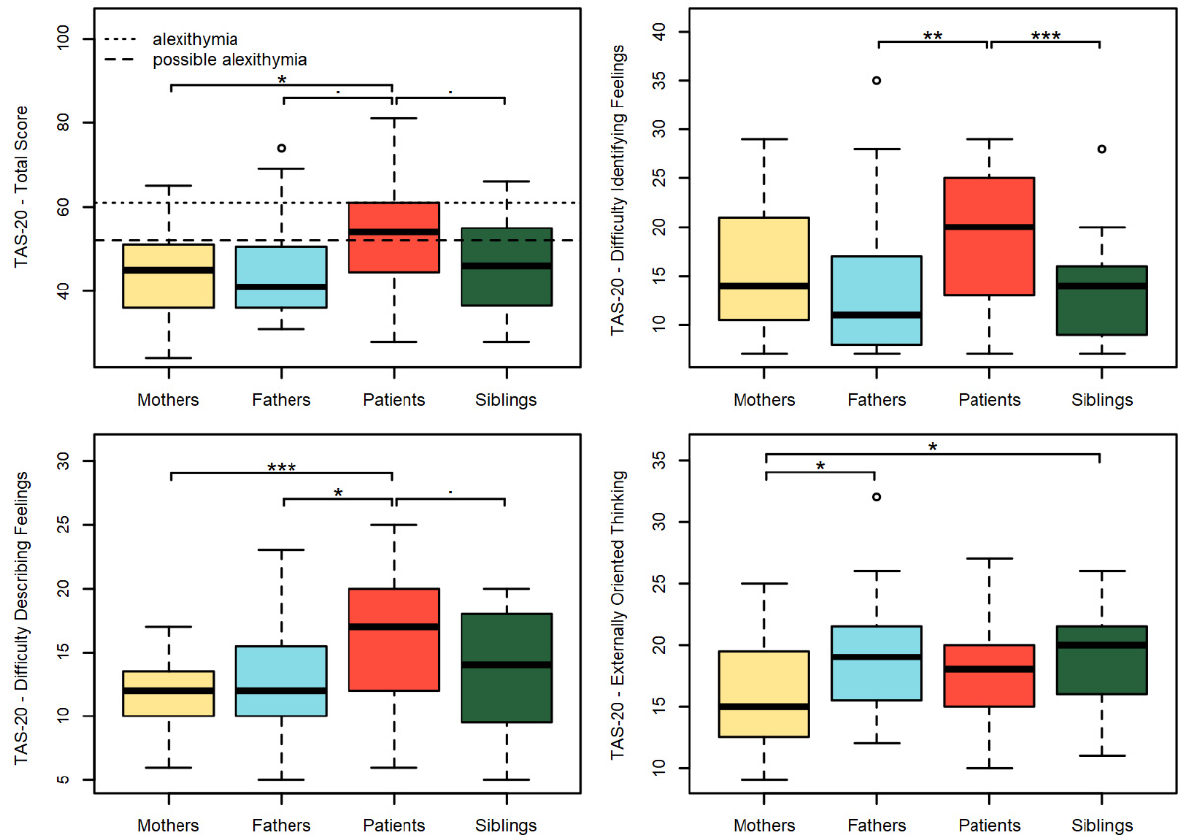
Figure 1. Alexithymia in family members. The boxplots represent the distributions of the TAS-20 scores of the different family members. The significant results of Bonferroni-corrected paired t-tests are reported for the following alpha levels: · = 0.1, * = 0.05, ** = 0.01, *** = 0.001, ◦ = outliers.